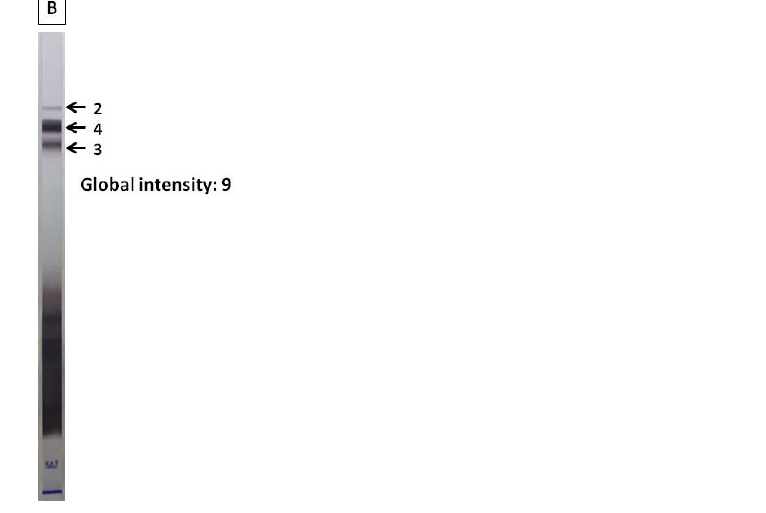
Figure 2. Examples of ICT and WB results from a CPA patient. ( A ) ICT positive result. ( B ) WB positive result with global intensity: 9.